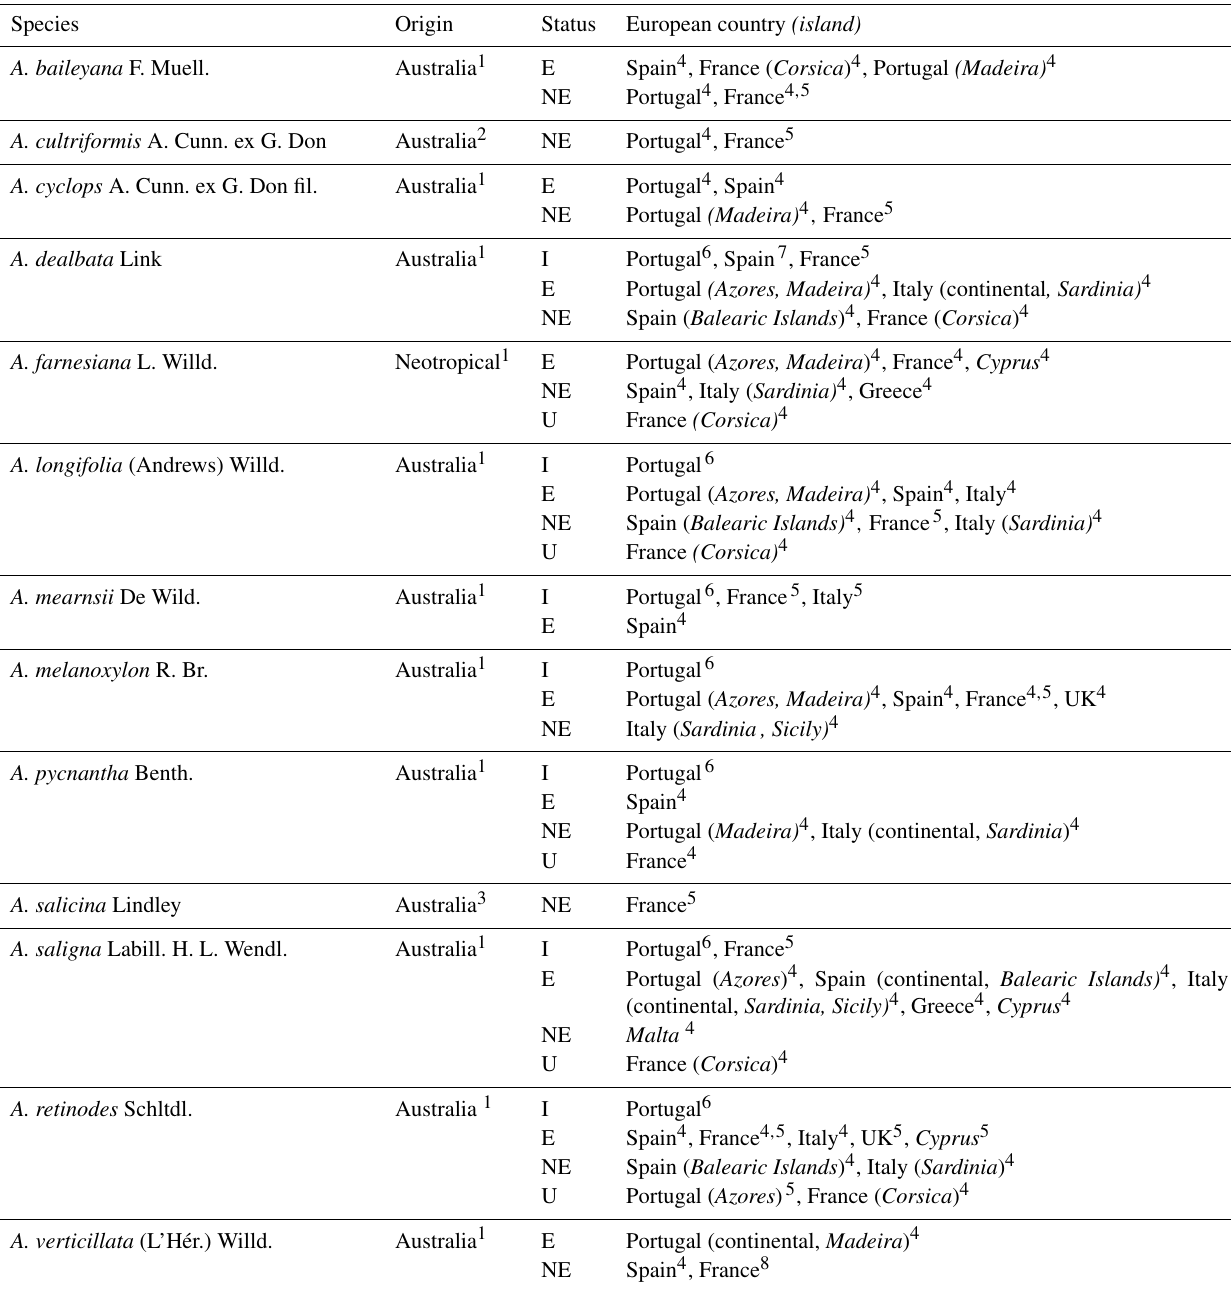
Table 1. Origin and status of the Acacia species registered in Europe in the wild as invasive (I), established or naturalized (E; as in Richardson et al., 2000), non-established (NE), or unknown